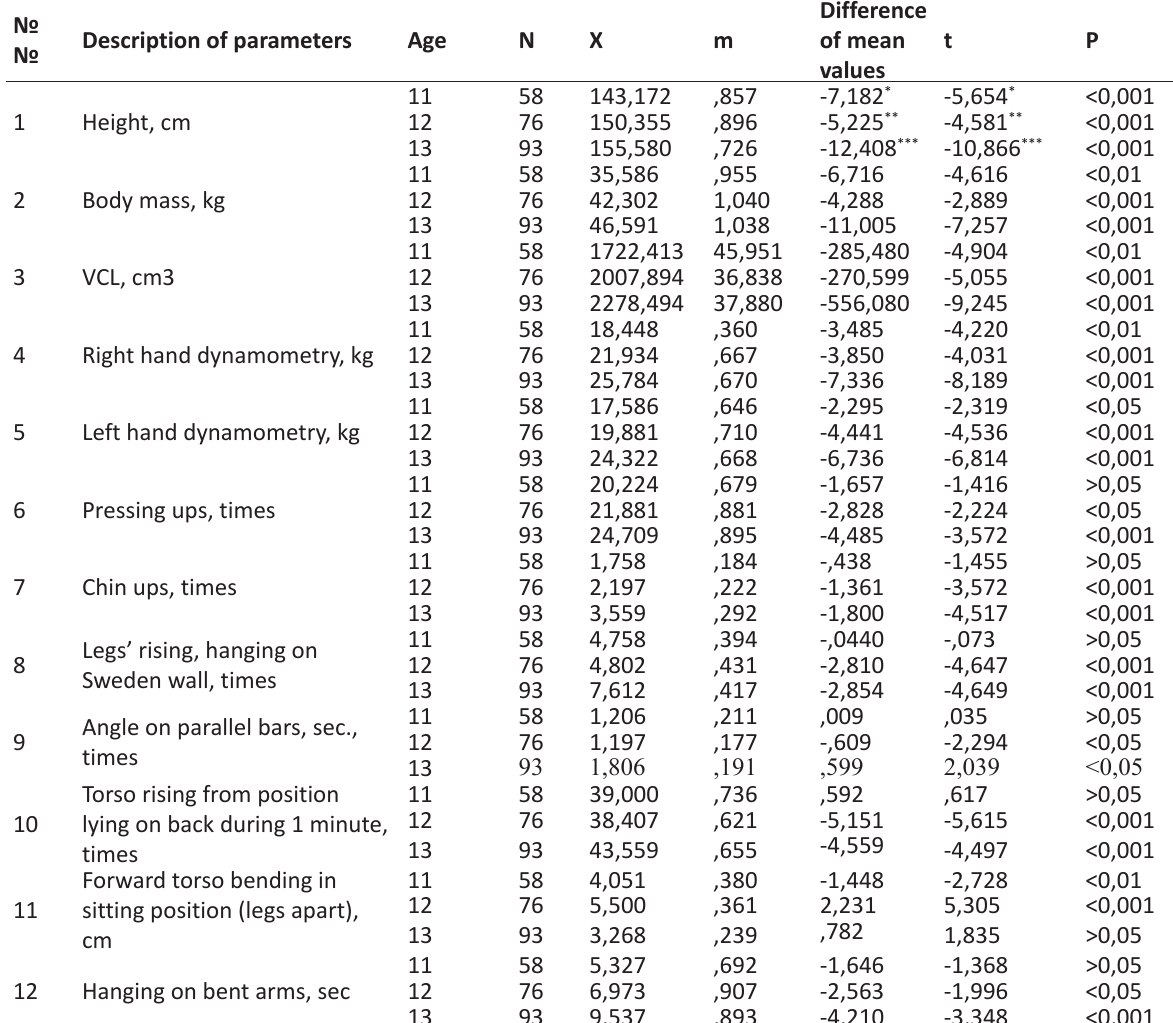
Table 1. T esting results of 11-13 yrs